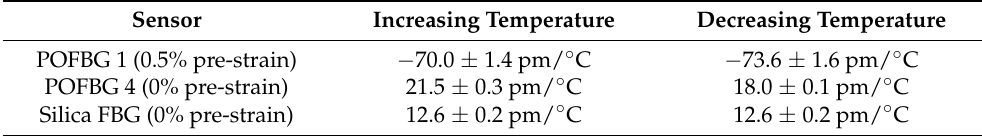
Table 2. Temperature sensitivities of sensors.